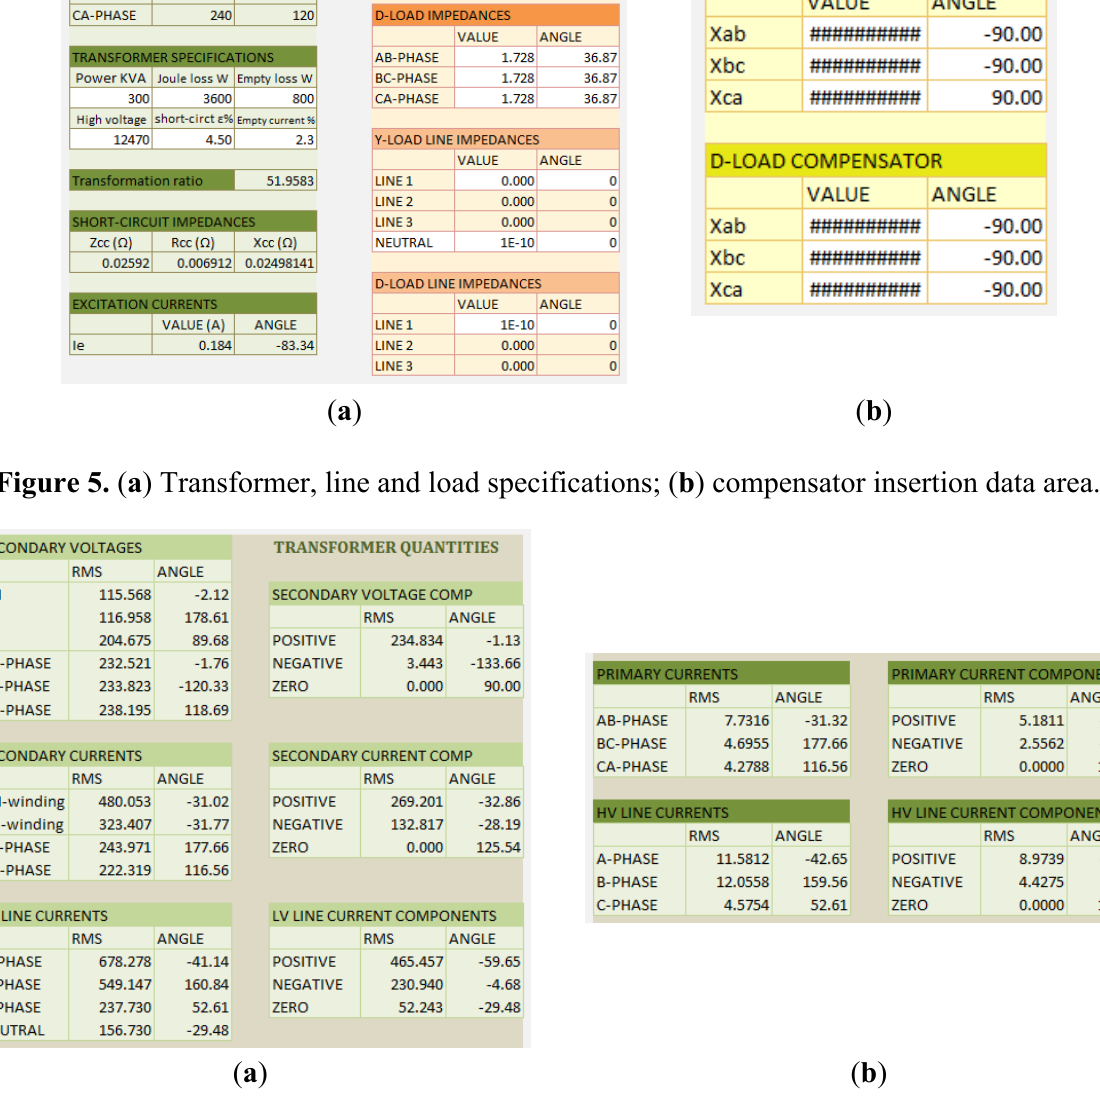
Figure 6. 4WD transformer voltages and currents: ( a ) secondary side; ( b ) primary